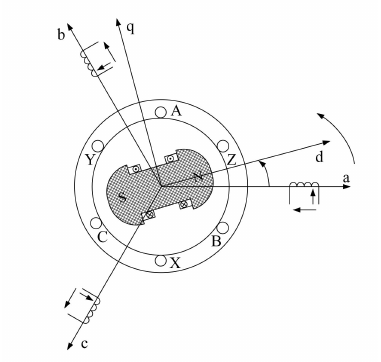
Figure 1. The physical model of interior permanent-magnet synchronous motor